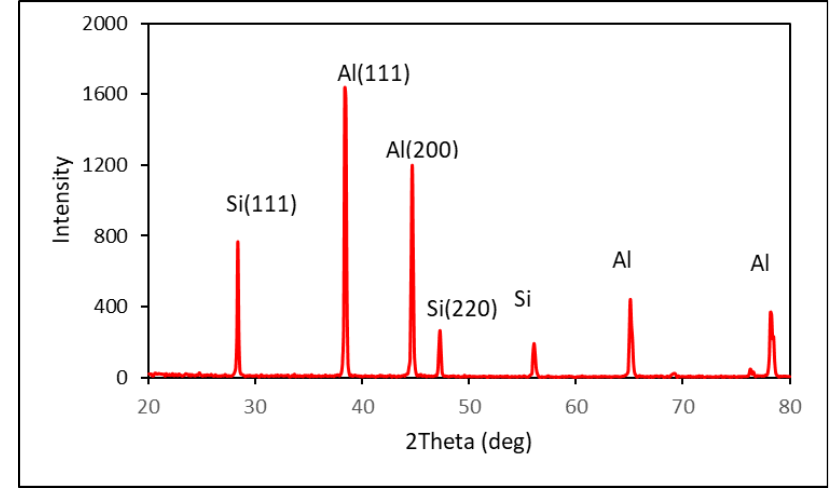
Figure 3: XRD pattern for Al-19.5wt%Si recycled